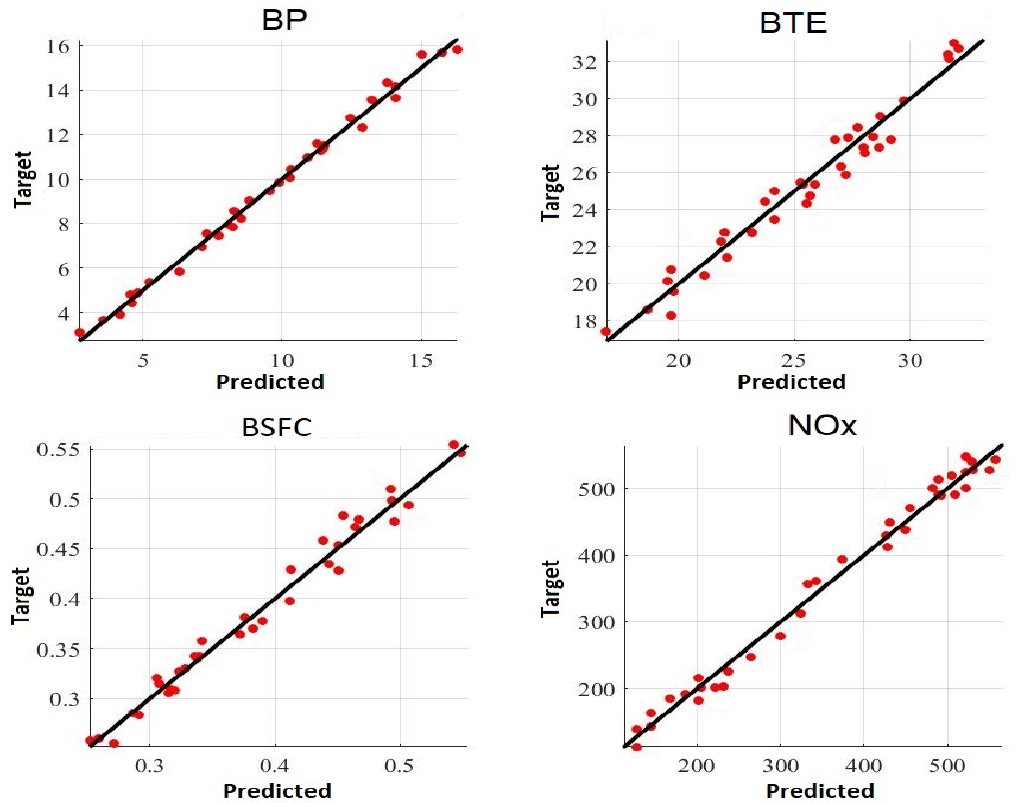
Figure 14. Regression model prediction precision.